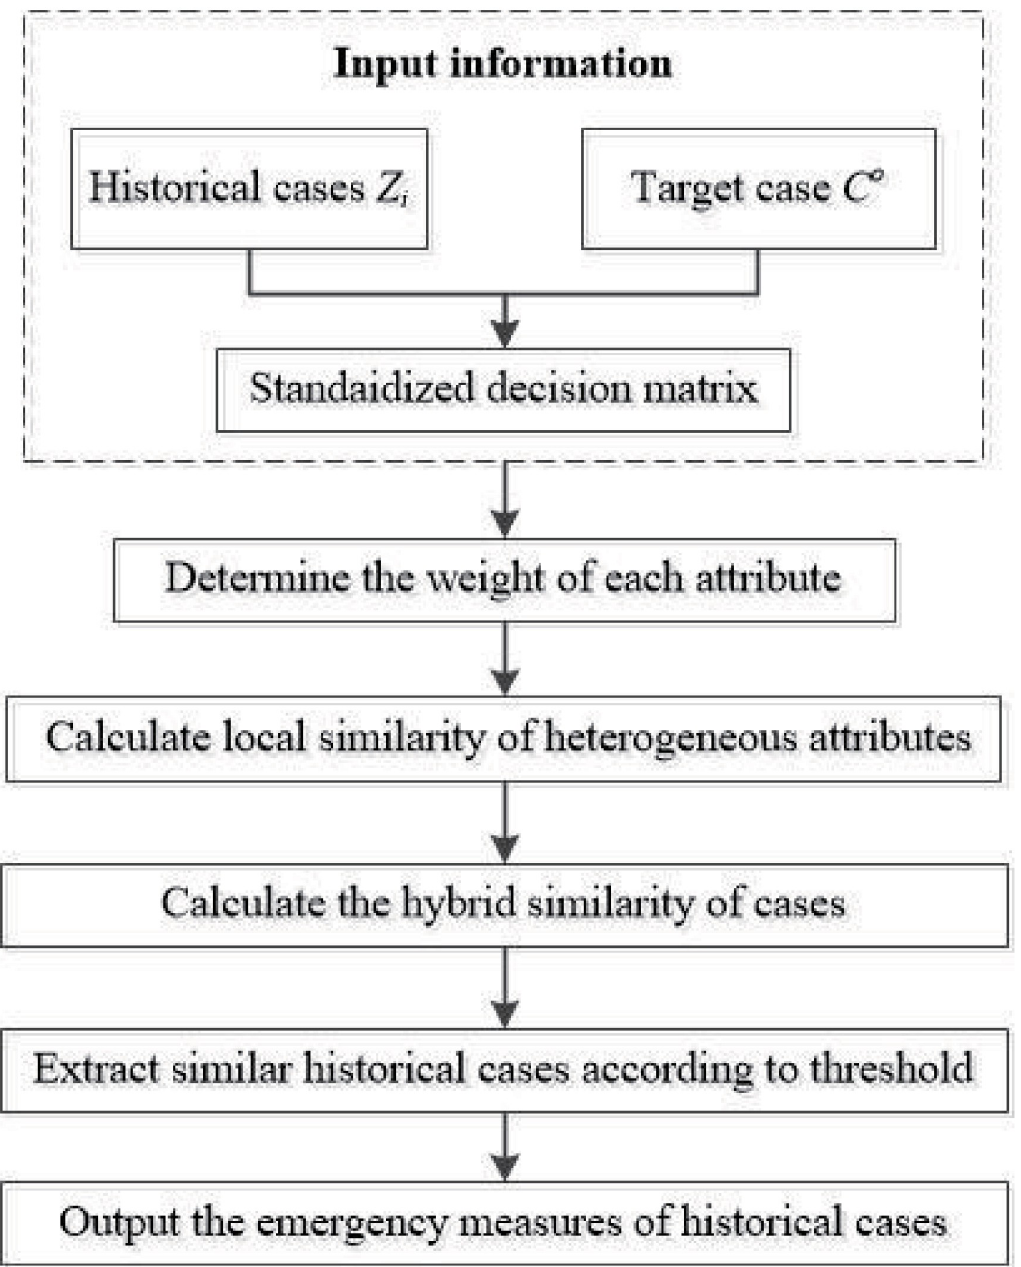
Fig 1. Flowchart of